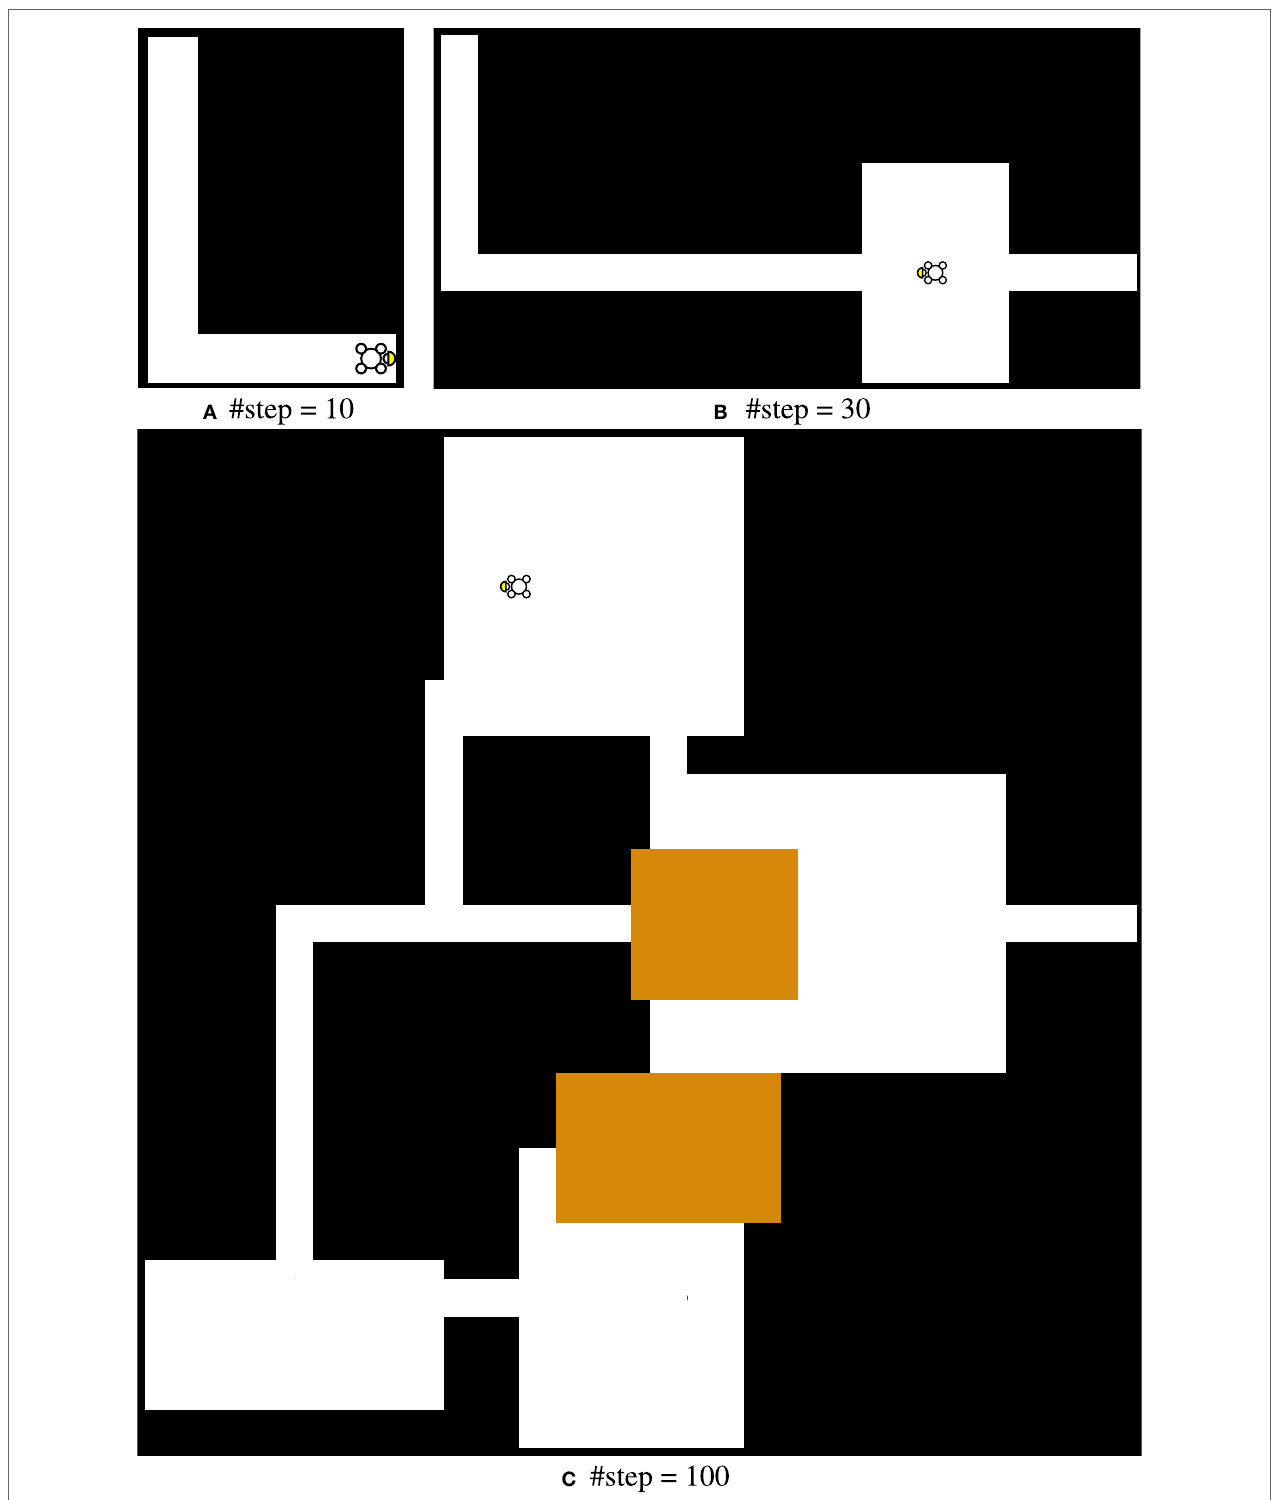
FigUre 2 | Illustration of an agent-based constructive approach to procedural content generation. (a) When moving, the agent leaves corridor trails. (B) It changes its direction and creates chambers at randomly. (c) An uninformed agent creates overlapping chambers (in